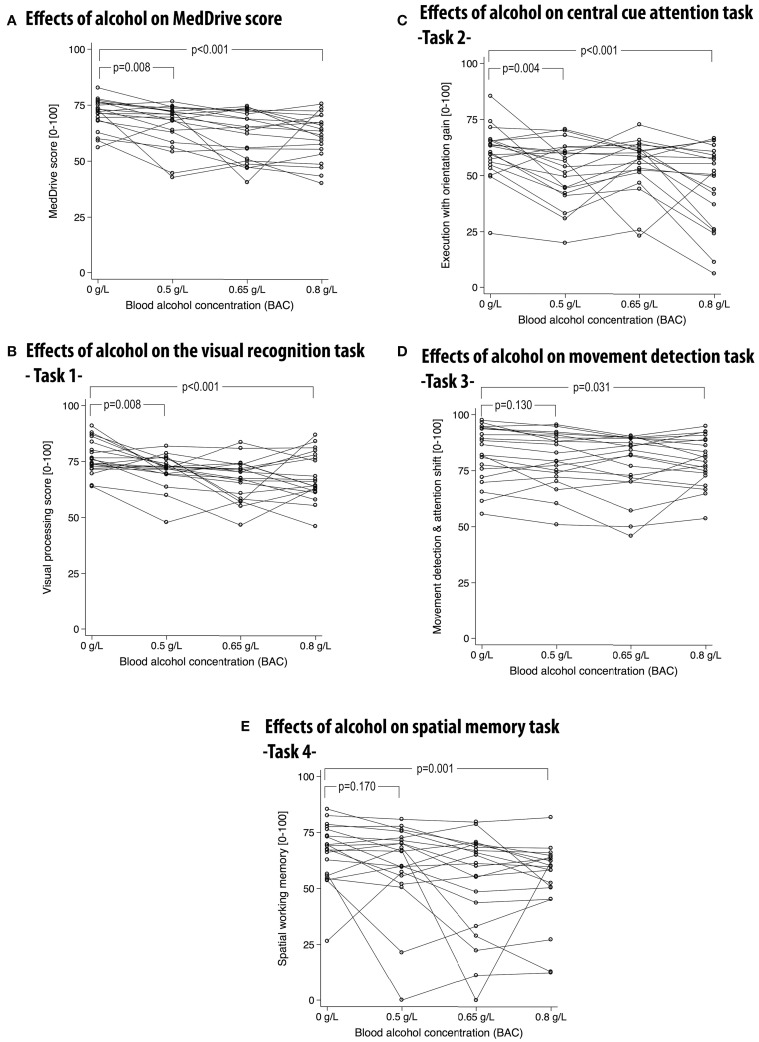
Effects of alcohol on the overall MedDrive score (A) and for each of its composing subtasks (B–E). MedDrive's responsiveness to different blood alcohol concentrations. Lines represent changes of performance across different blood alcohol concentrations (BACs). Lower scores represent worse performance. P-values correspond to Wald's test of significance comparing differences in performance between the control condition (BAC = 0 g/L) and other BACs. BAC, blood alcohol concentration.